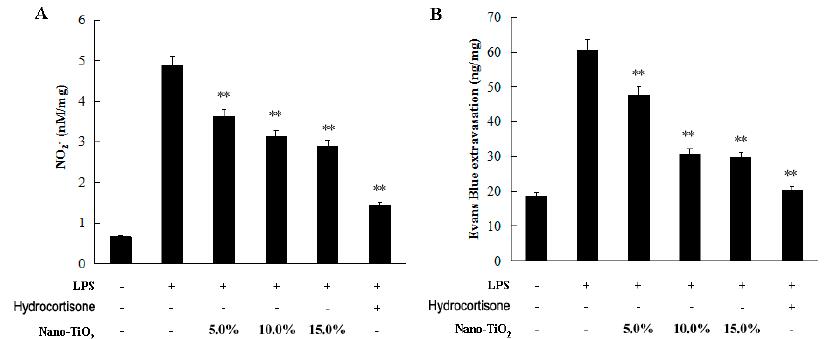
Figure 4. Effects of nano-TiO 2 ointment on inhibiting vascular permeability. Ointment contained 5.0%, 10.0%, and 15.0% of nano-TiO 2 were rubbed on the depilated dorsal skin of rats. ( A ) NO 2 − in the skin was detected using the Griess method; ( B ) Evans blue dye extracted from the skin was measured. Data were shown as means ± SD of three independent experiments. ** p < 0.01 against control group.